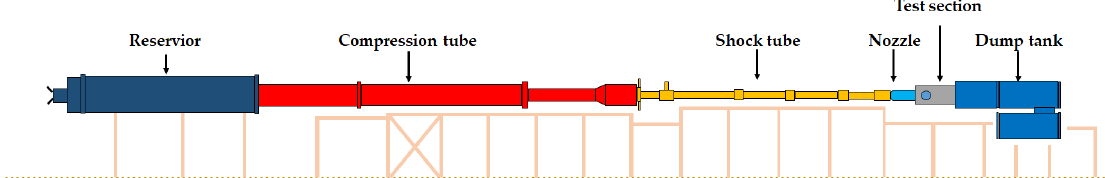
Figure 1. Schematic of the T4 shock tunnel [2].